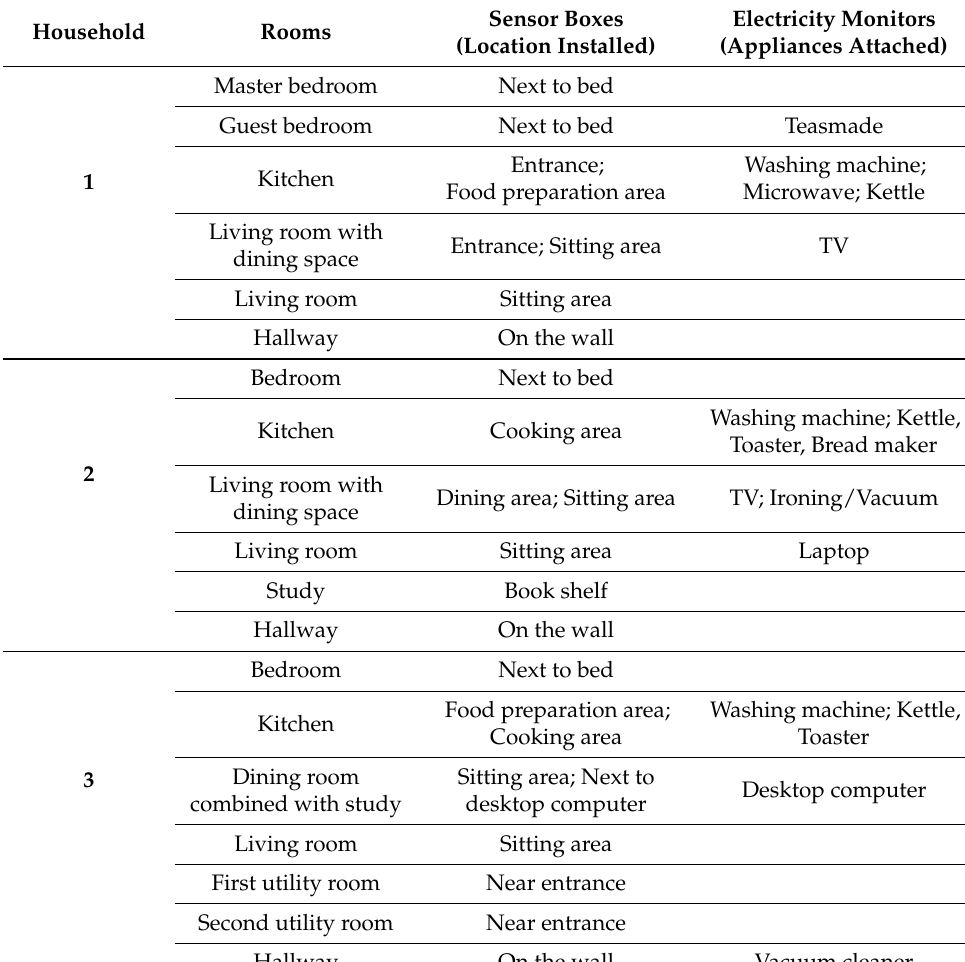
Table 2. Sensors installed in each trial